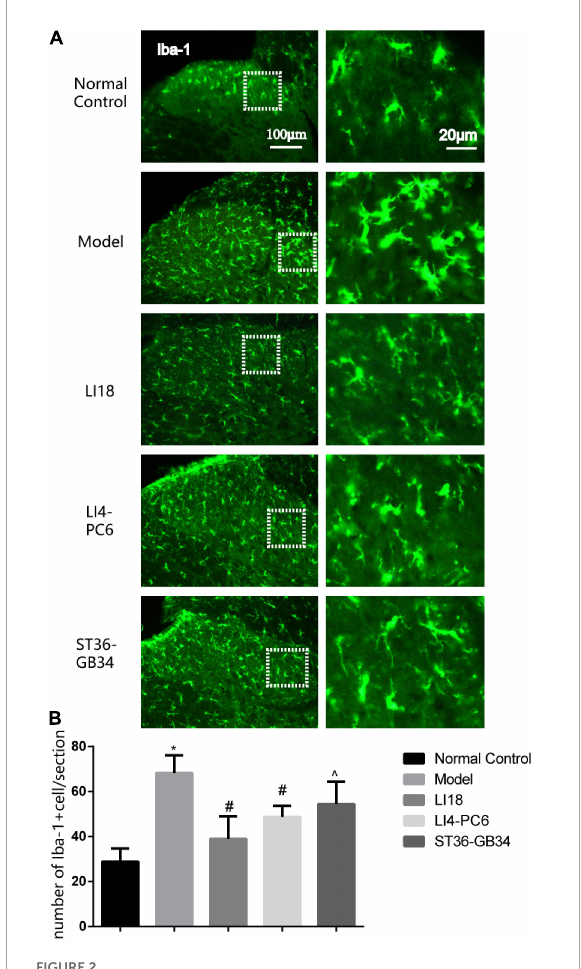
FIGURE2 Comparison of the effects of electroacupuncture (EA) on activities of microglia in the dorsal horns (DHs) of cervical (C2–C5) spinal cord at 24 h after neck incision in different groups (mean ± SD, n = 5/group). (A) Representative fluorescence micrographs of immunofluorescent staining of ionized calcium-binding adapter molecule 1 (Iba-1) for microgliacytes in the spinal DHs in different groups. The magnified microglial cells shown in the right column images were chosen from the dashed squares of the left column images in the five groups. The scale bar in the five images on the left column is 100 µ m, and 20 µ m in the five images on the right column. (B) Bar graphs showing the numbers of microglia in the DHs of spinal cord at 24 h after incision in different groups. One-way ANOVA revealed that the number of Iba-1 immunoreaction (IR) positive cells was significantly increased in the model group (vs. the control group) and considerably decreased in both EA LI18 and EA PC6-LI4 groups but not in the EA ST36-GB34 group (vs. the model group). * P < 0.01, vs. the control group, # P < 0.05, vs. the model group, ˆ P < 0.05, vs. the EA LI18